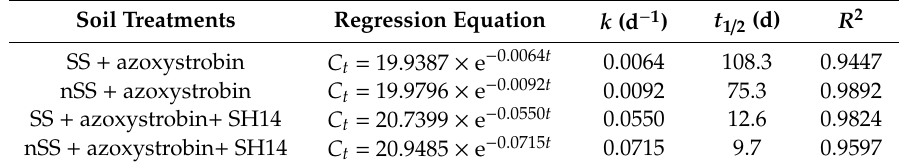
Table 5. Kinetic parameters of azoxystrobin degradation in sterile and non-sterile soils. Soil Treatments